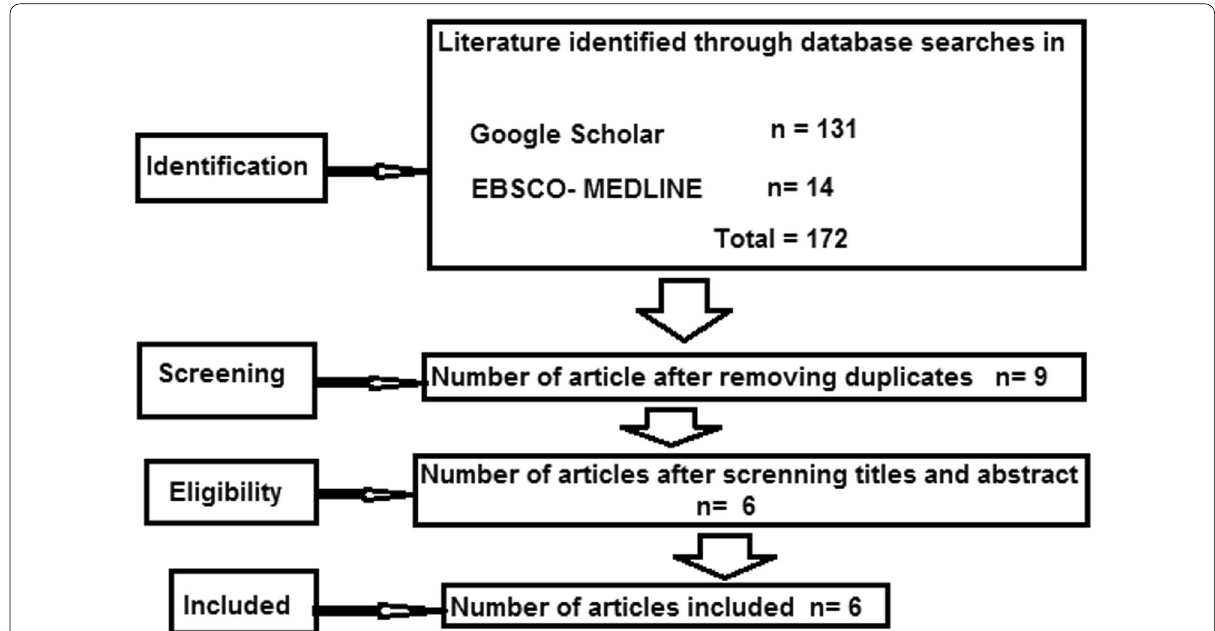
Fig. 1 Flow diagram for the review process used for the